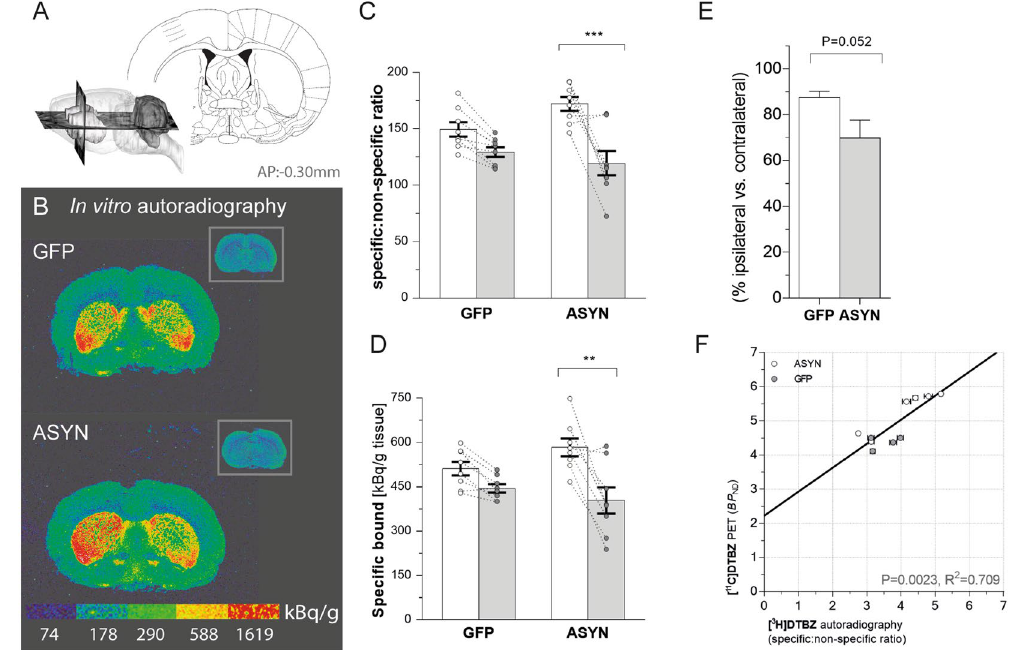
Figure 3. in vitro DTBZ[ 3 H] autoradiography. Sketch showing the coronal section at − 0.30 mm from bregma (from Paxinos & Watson, The rat brain in stereotaxic coordinates (Academic Press/Elsevier) used for autoradiography ( A ). Representative autoradiograms of [ 3 H]-labeled DTBZ ( B ) and the insets show the non- specific binding in presence of cold DTBZ in striatal sections form GFP (top) and ASYN animals (bottom). Color scale indicates activity of bound radioligand in k Bq/g tissue. ( C ) Bars represent the specific:non-specific ratio of autoradiographic signal in each side of striatum per group. There was a significant reduction of the ligand binding in ASYN animals. Two-way ANOVA (Interaction: rAAV & side F(1,28) = 4.99 P = 0.03; rAAV effect F(1,28) = 0.76 P = 0.39; side effect F(1,28) = 24.85 P < 0.0001), followed by Tukey’s multiple comparisons (GFP n = 8 & ASYN n = 8). ( D ) Consistently, quantification of specifically bound [ 3 H]DTBZ showed similar decrease in ASYN animals. Two-way ANOVA (Interaction: rAAV & side F(1,28) = 3.52 P = 0.07; rAAV effect F(1,28) = 0.27 P = 0.6; side effect F(1,28) = 17.08 P = 0.0003); followed by Tukey’s multiple comparisons. * P < 0.05, ** P < 0.01, *** P < 0.001. ( E ) Shows the data as percentage of the contralateral side (unpaired t-test, t = 2.13, DF = 14, P = 0.052). The correlation of in vitro autoradiography and in vivo PET DTBZ binding ( F ) yielded a significant linear relationship (R 2 = 0.71, P < 0.005). In F: each point corresponds to individual estimates from animals, which underwent both methods. Horizontal standard error bars represent the variation of triplicate values for each individual rat in the autoradiography quantification; and the vertical error bars, the individual mean square error in the linear regression for binding potential